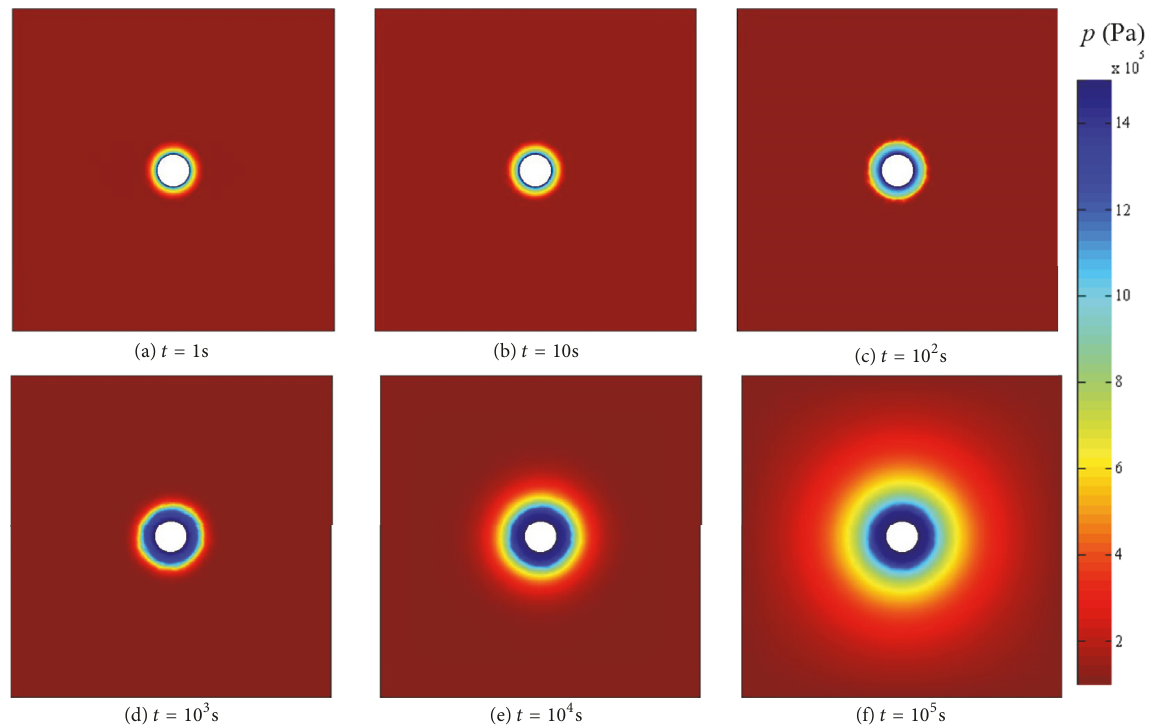
Figure 10: Gas pressure distribution of borehole surrounding rock.